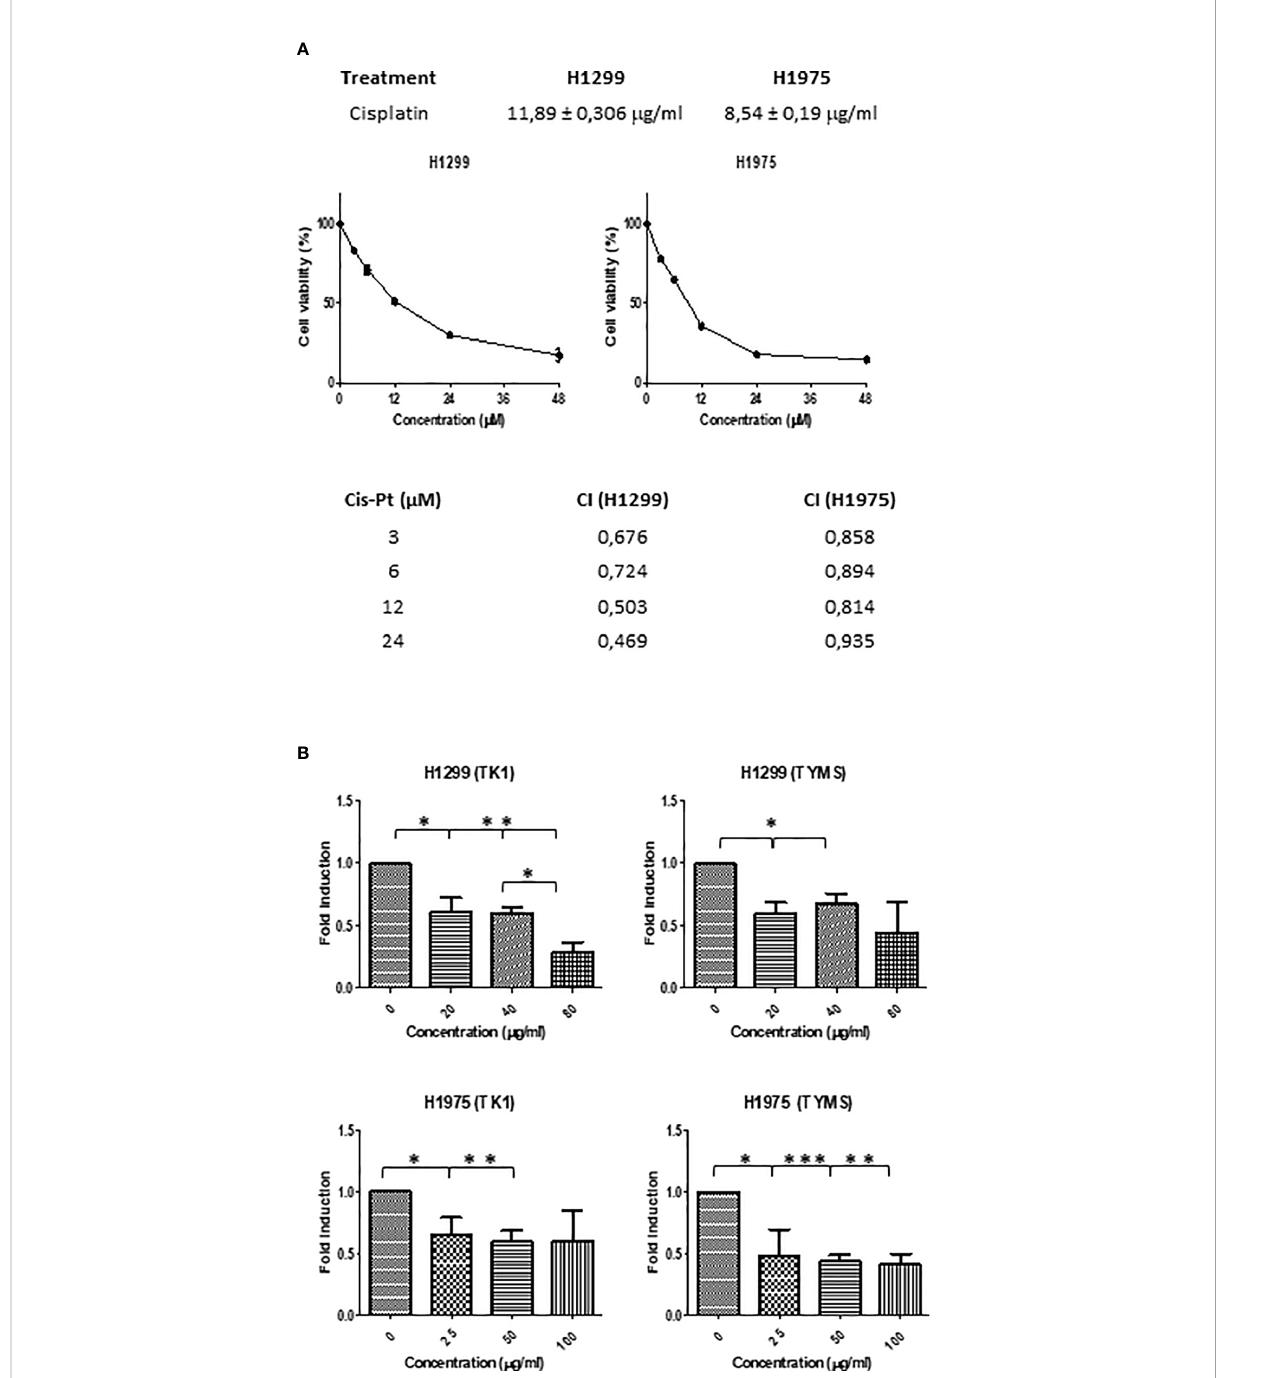
FIGURE 7 (A) Dose – response curves of the cell proliferation after 48 h of treatment with cisplatin in NSCLC H1299 and H1975. IC 50 values after cisplatin treatment in the two different NSCLC cell lines (H1299 and H1975) after 48h of treatment are indicated (upper panel). SFRE synergised with cisplatin in the inhibition of NSCLC cell proliferation. NSCLC cells were pre-treated with the extract for 3h at a fi xed dose of 1/2 IC 50 for H1299 and H1975. Combinatory index (CI) according to Chou – Talalay method (lower panel). (B) SFRE diminished the expression of TK1 and TYMS , in a dose dependent manner. Results are shown in relation to non-treated cells and normalized to the endogenous control B2M . Results are expressed as the mean ± SEM of three independent experiments, each performed in triplicates. Asterisks *, **, *** indicate p-values < 0.05, 0.01 and 0.005,